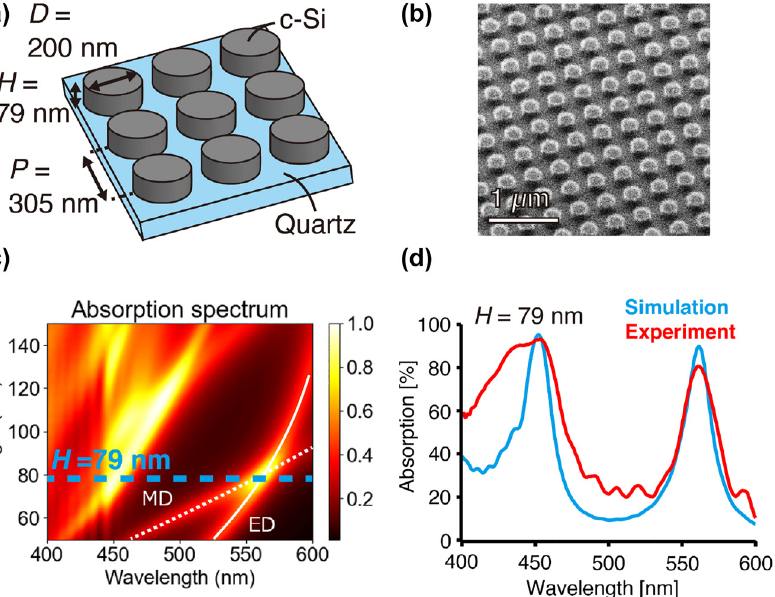
Figure 2: Absorption properties of the silicon metasurface. (a) Structure design schematic. (Abbreviation, D: diameter, H: height, P: period, c-Si: crystalline-silicon) (b) SIM image of the fabricated silicon metasurface. (c) Absorption spectral map of silicon metasurface for different heights of the meta-atoms. The diameter and the period of silicon nanodisc meta-atoms are 200 and 305 nm, respectively. The surrounding medium is air ( n = 1). Blue dotted line indicates the height of 79 nm. White solid and dotted lines indicate the locations of ED and MD modes, respectively. (d) Absorption spectra agree well between simulation (blue line) and experiment (red line), showing a resonance peak of Huygens’ dipole at 561